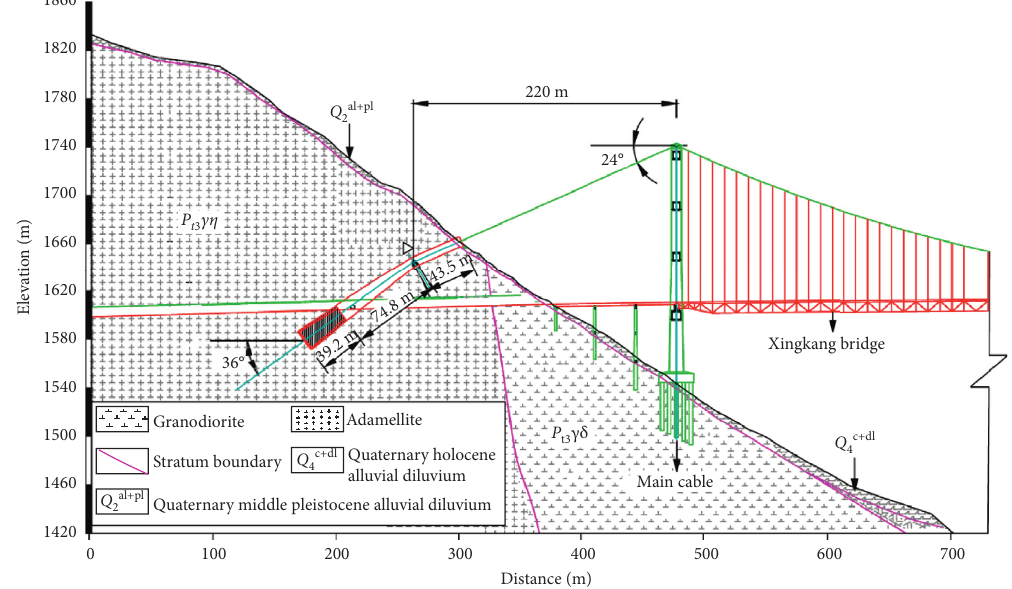
Figure 2: Engineering geology profile at the I-I position of Figure